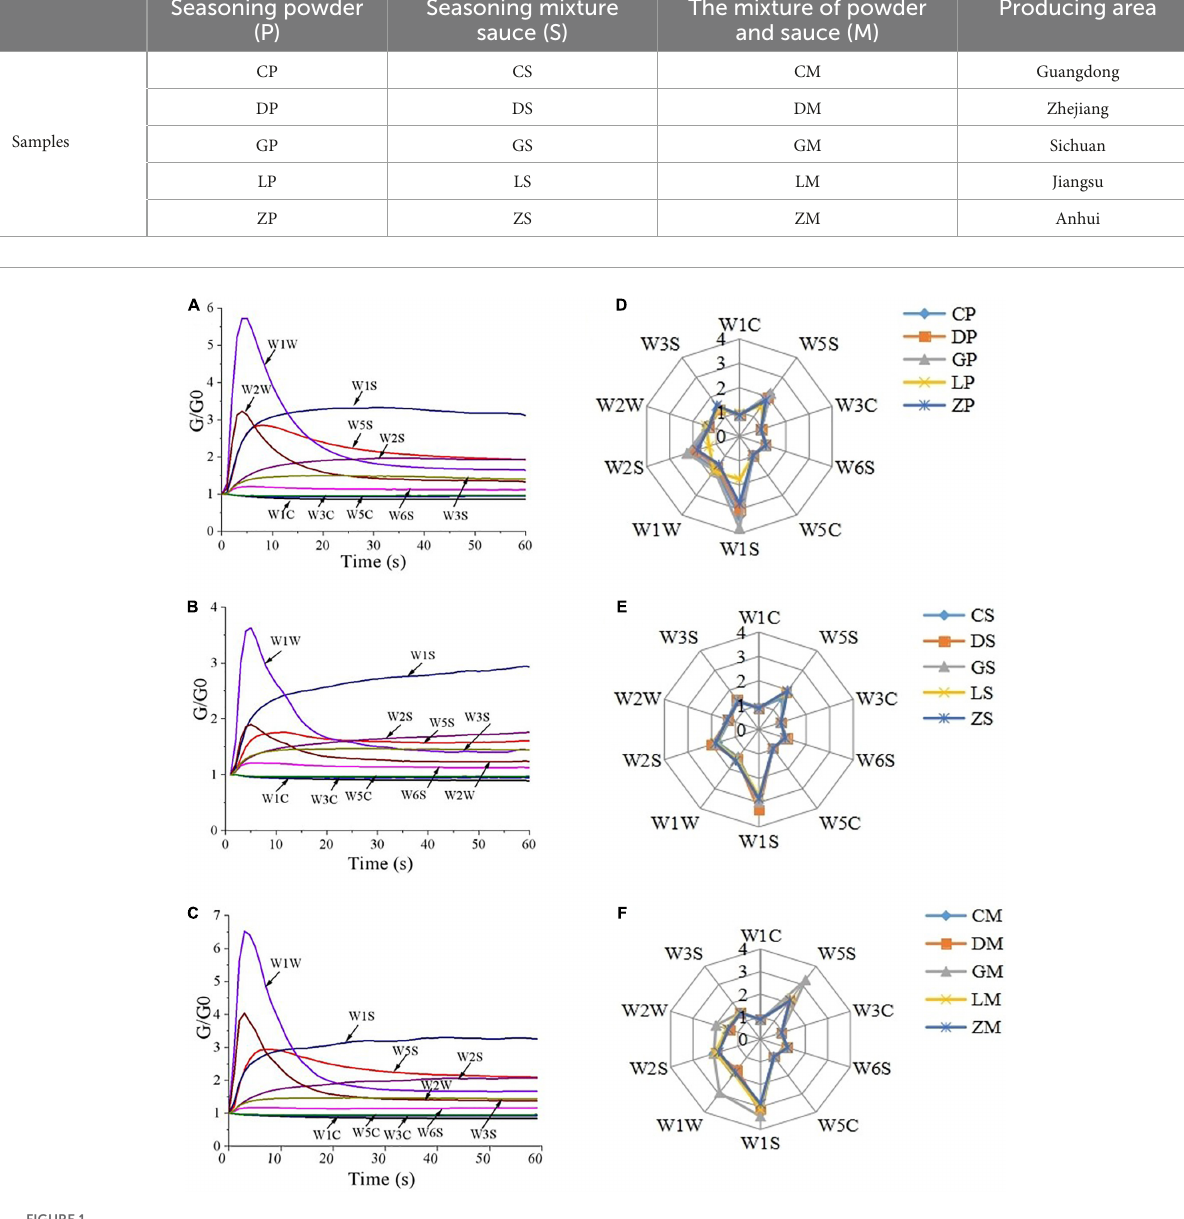
FIGURE1 E-nose responses to instant starch noodles seasonings of CP (A) , CS (B) and CM (C) , and radar plots of 10 e-nose sensor responses for seasoning powder (D) , seasoning mixture sauce (E) and the mixture of powder and sauce (F)